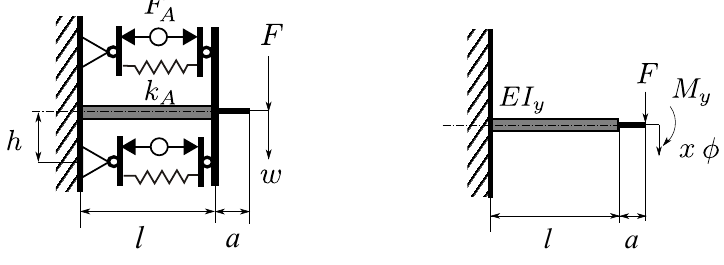
Figure 6. Mechanical sketch of the adaptive vibration